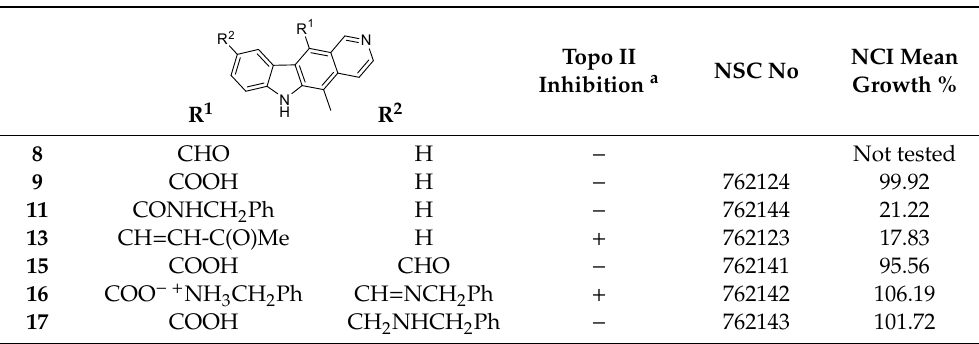
A = Positive Control (kDNA+ATP+Topo II); B = Negative Control (kDNA + ATP + Topo II + 100 µM Ellipticine); Consequent lanes all screened at 100 µM: 1 = Ellipticine 1; 2 = 9-Methoxyellipticine 2; 3 = 9-Formylellipticine 19; 4 = 9-Hydroxyellipticine 4; 5 = 8; 6 = 9; 7 = 13; 8 = 15; 9 = 16; 10 = 17; 11 = 11.